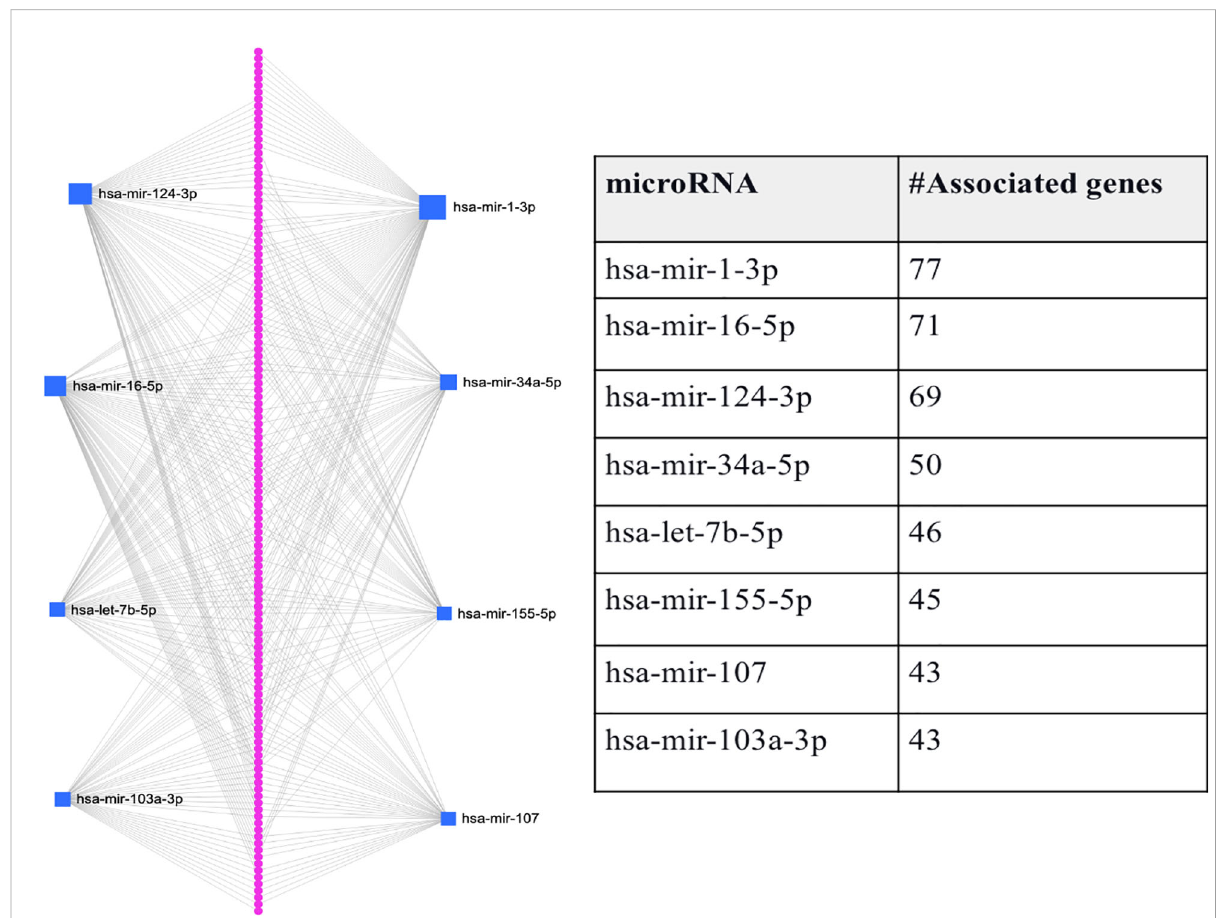
FIGURE 3 Graphical representation of the top-ranked miRNAs predicted to target the 146 DEGs associated with T2D and its comorbidity, Alzheimer ’ s disease. The pink dots arranged linearly are a series of nodes representing the DEGs targeted by the miRNAs, while the blue squares indicate the miRNAs. The size of the square indicates the degree (the number of targeted genes); that is, the bigger the number of genes targeted by the miRNA, the bigger the size of the